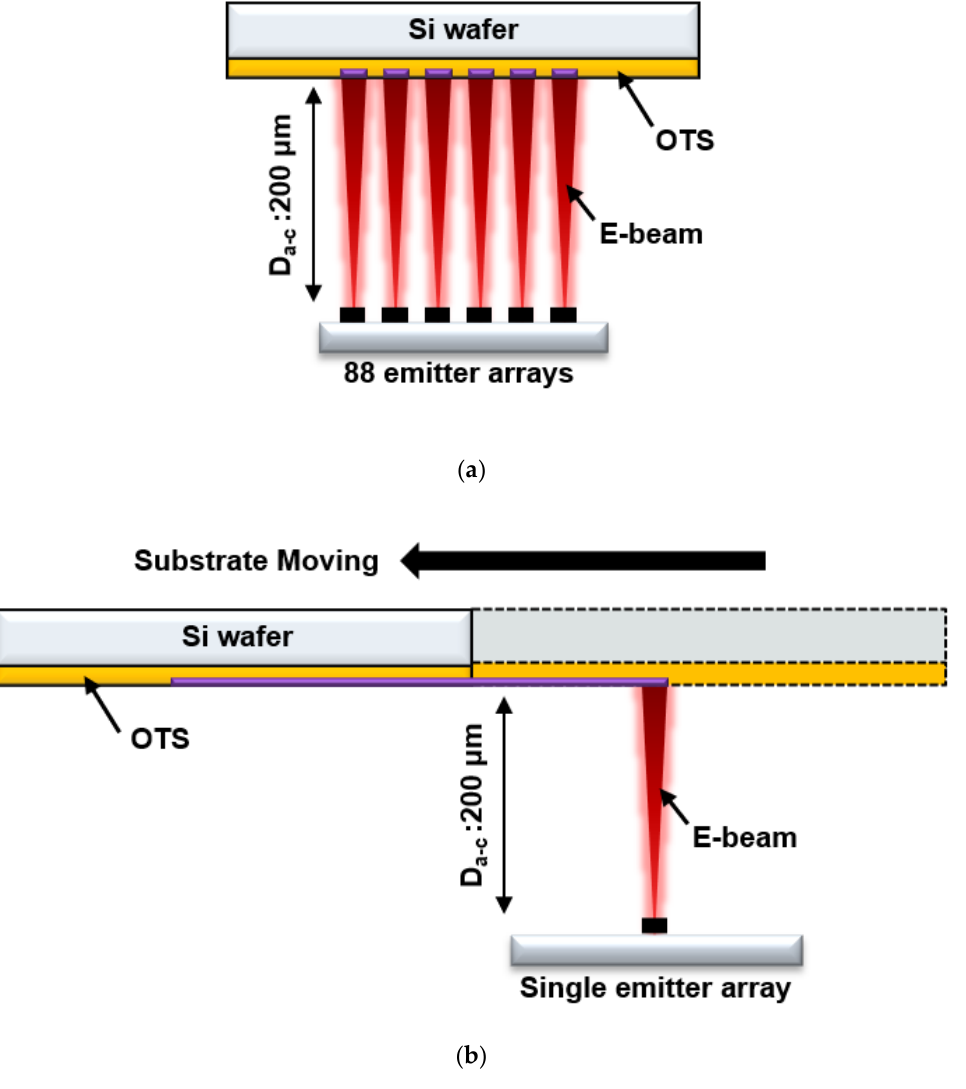
Figure 3. Schematic diagrams for ( a ) water contact angle measurement and EDX mapping analysis using an 88-island emitter array of VACNTs and ( b ) line patterning of Si wafer using VACNT single-island emitter array.